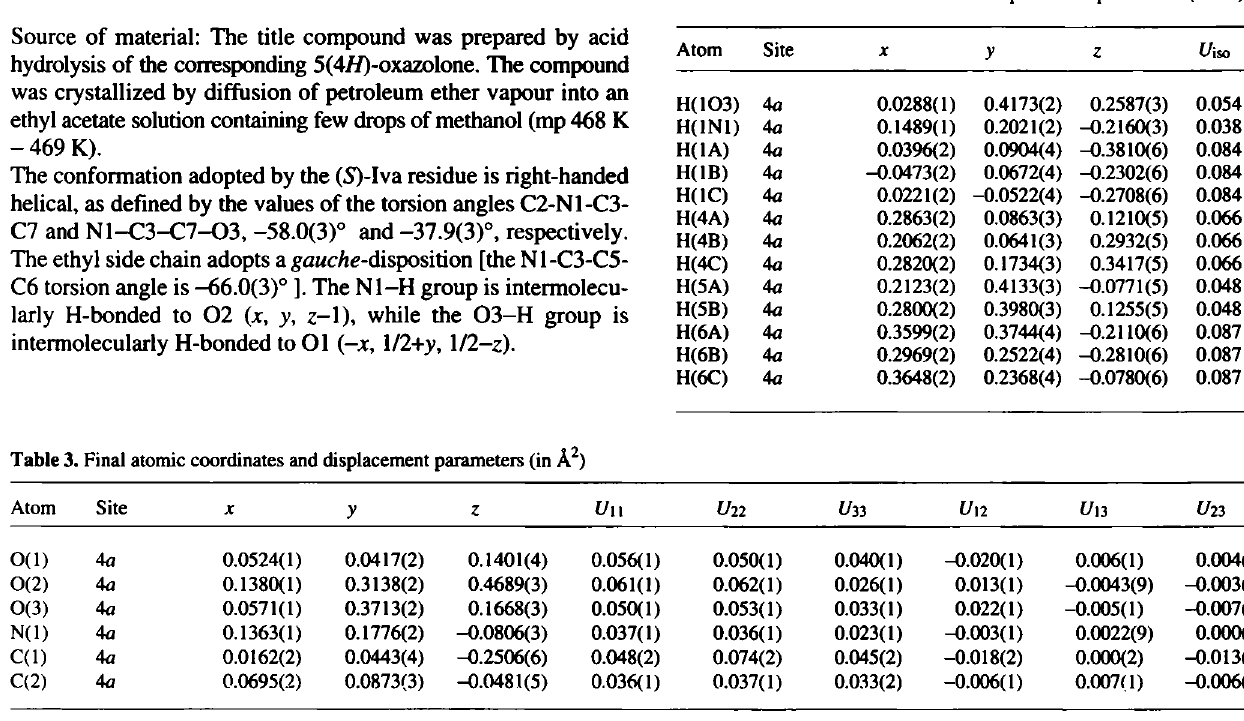
Table 2. Final atomic coordinates and displacement parameters (in